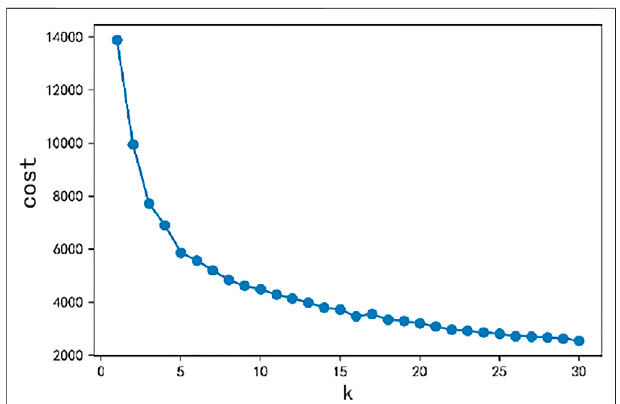
FIGURE 3 | Cost function value of different